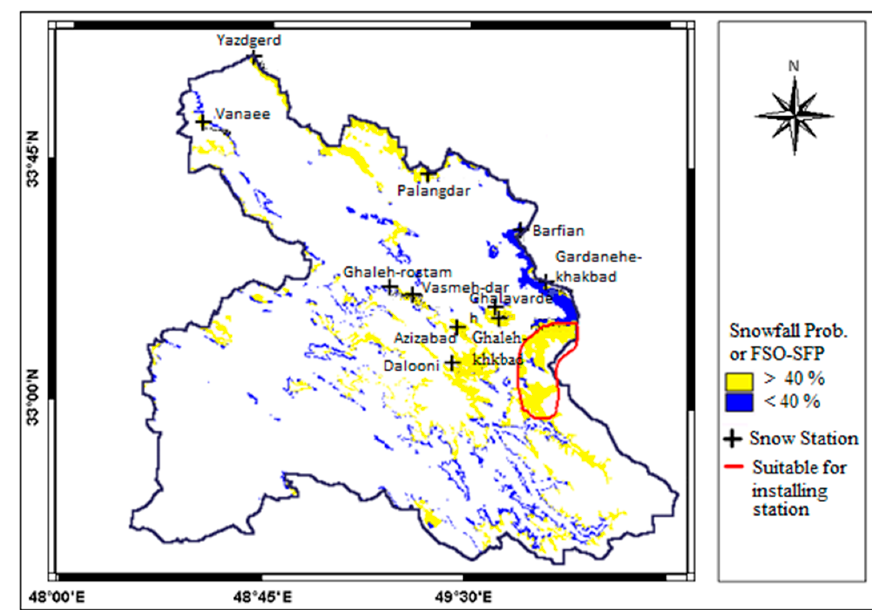
Figure 8. Selected zone for new snow stations and the existing station network in 2250–2500 m elevation interval in Dez Basin.